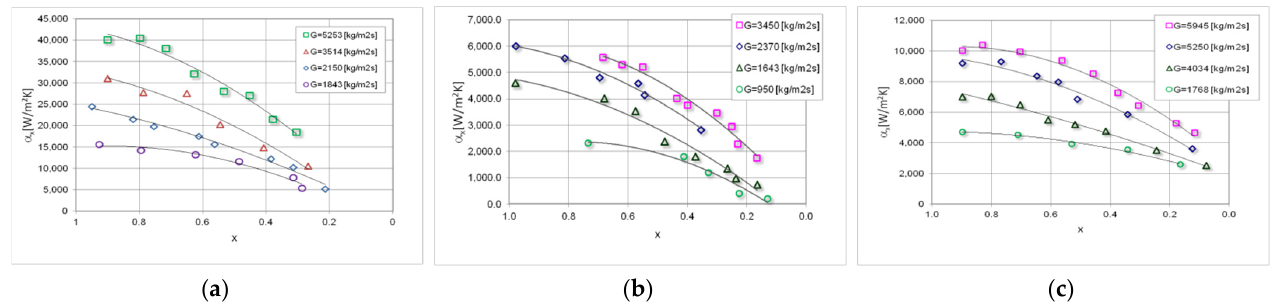
Figure 7. Experimental, local characteristics of heat transfer coefficient α x depending on the vapour quality x during the condensation in a mini-channel with a hydraulic diameter d h = 0.8 mm, re- frigerant: ( a ) HFE7100; ( b ) Novec649; ( c ) HFE7000.